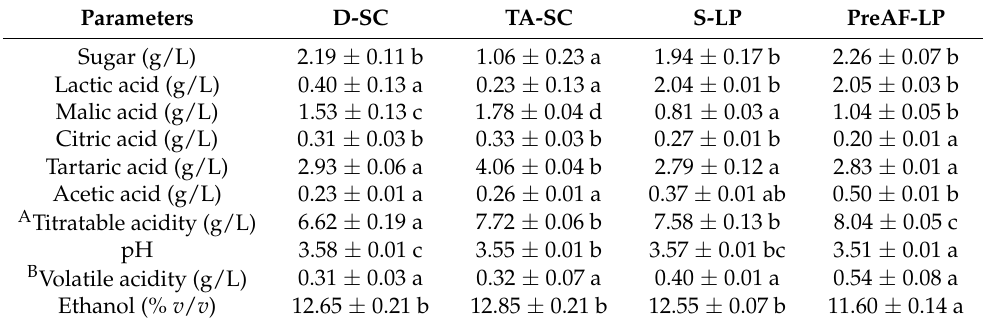
Table 1. Basic oenological parameters of the Cabernet Sauvignon wines obtained from four different fermentation modalities. Parameters D-SC TA-SC S-LP PreAF-LP Sugar (g/L) 2.19 ± 0.11 b 1.06 ± 0.23 a Lactic acid (g/L) 0.40 ± 0.13